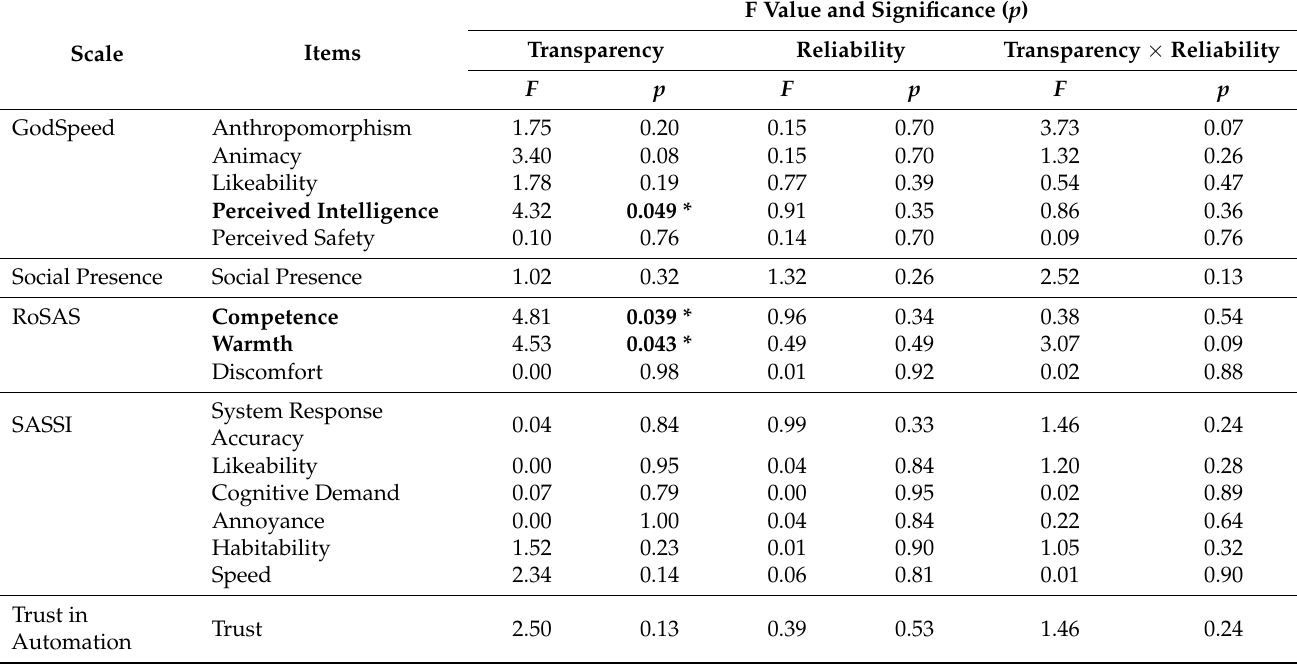
Table 5. Subjective evaluation